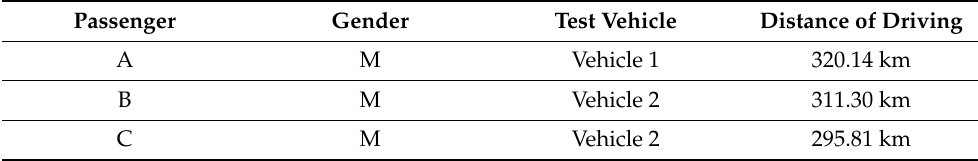
Table 1. Information on the vehicles and passengers for actual driving.